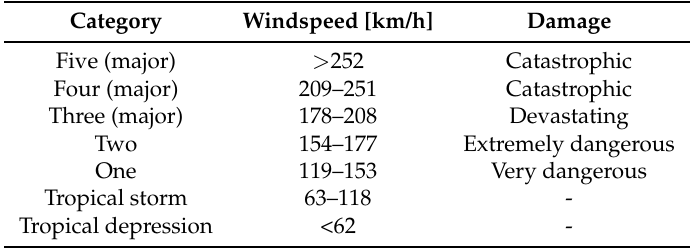
Table 3. Classification of tropical cyclones according to the Saffir–Simpson scale (for hurricanes) and other related classifications. Wind speed refers to the 1-min maximum sustained